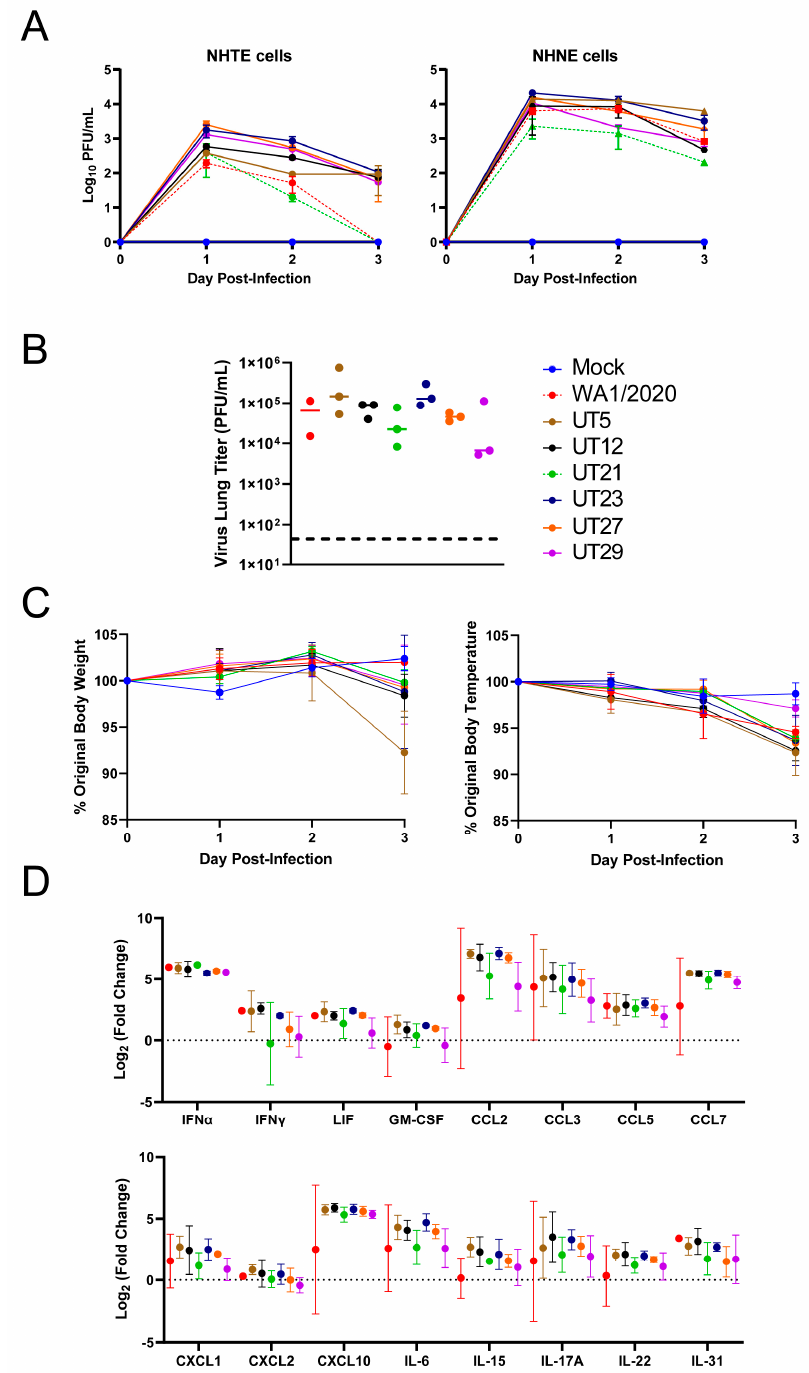
Figure 2. Evaluation of SARS-CoV-2 variants in primary epithelial cells and K18-hACE2 mouse model. ( A ) Normal human primary tracheal epithelial cells (NHTE) and normal human primary nasal epithelial cells (NHNE) were inoculated with a MOI = 1 and virus titer were assessed at 1 to 3 dpi with a plaque assay. Data are represented as mean ± standard error of the mean. Virus isolates within the A lineage, WA1/2020 (red), and A.1, UT21 (green), are represented by dashed lines. Virus isolates within the B.1 lineage, UT12 (black), UT23 (navy blue), UT27 (orange), and UT29 (violet), and B.1.577, UT5 (brown), are represented by solid lines. In B-D, female K18-hACE2 mice were intranasally challenged at 10 4 PFU with either SARS-CoV-2 WA1/2020 ( n = 2) or one of six clinical isolates UT5, UT12, UT21, UT23, UT27, or UT29 ( n = 3). Graphs of lung viral titers ( B ), weight and body temperature ( C ), or selected immune responses in lung ( D ) are